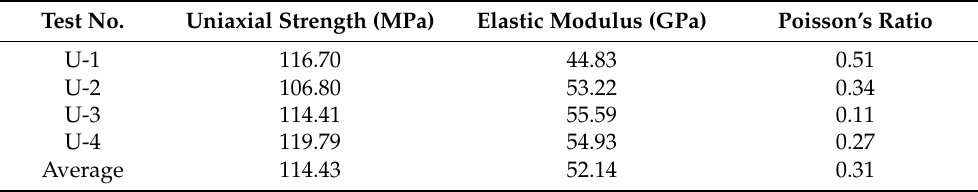
Table 2. Statistics of uniaxial compression test results.